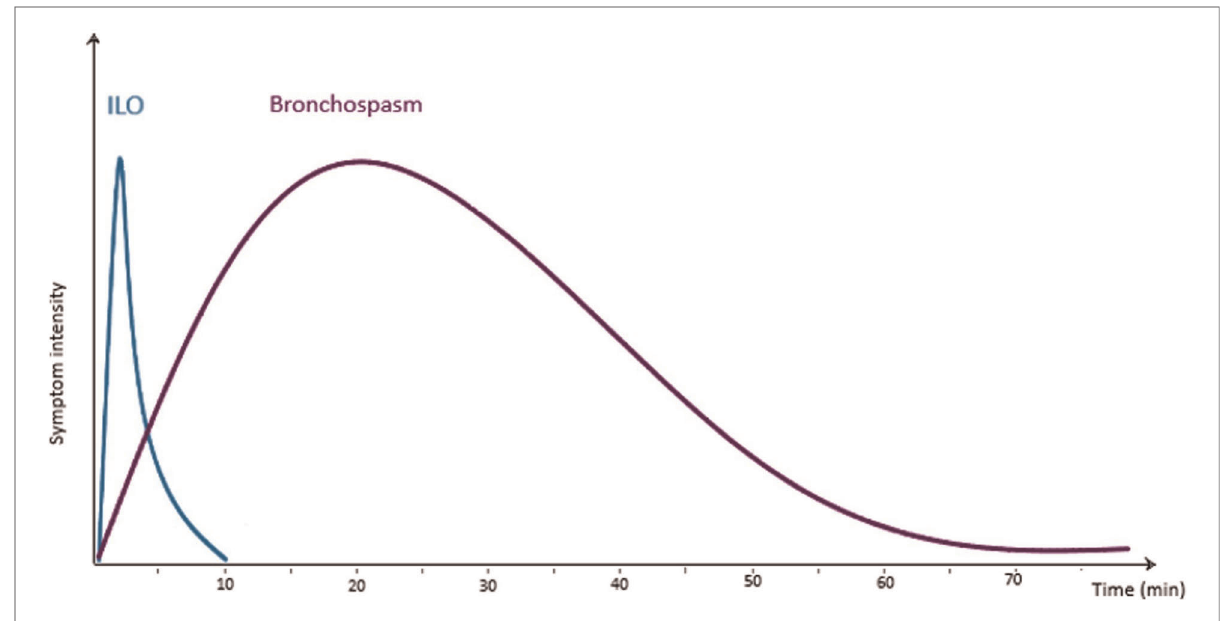
FIGURE 1 Approximate average timescale of symptoms of ILO and bronchospasm in relation to a triggering